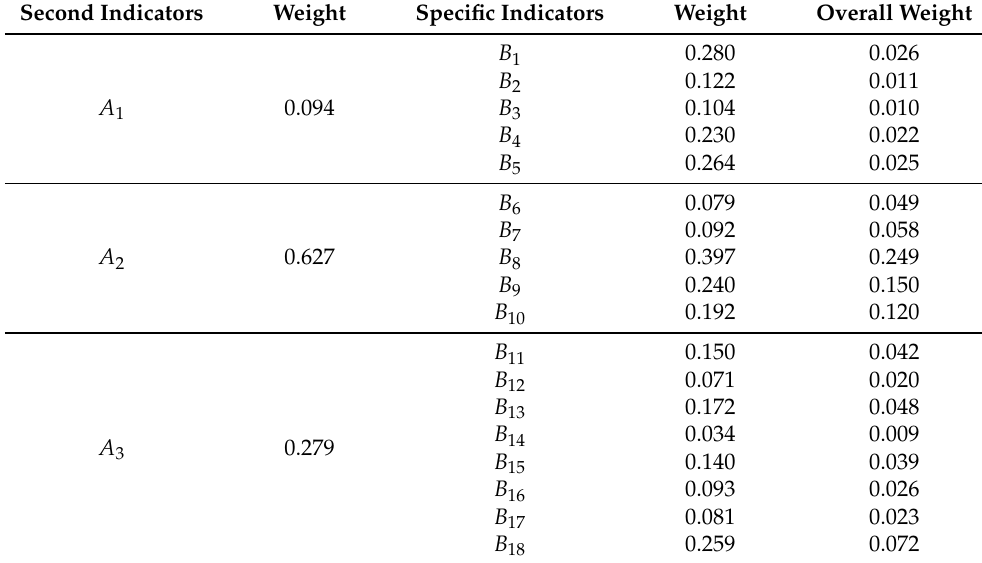
Table 6. Weights of all